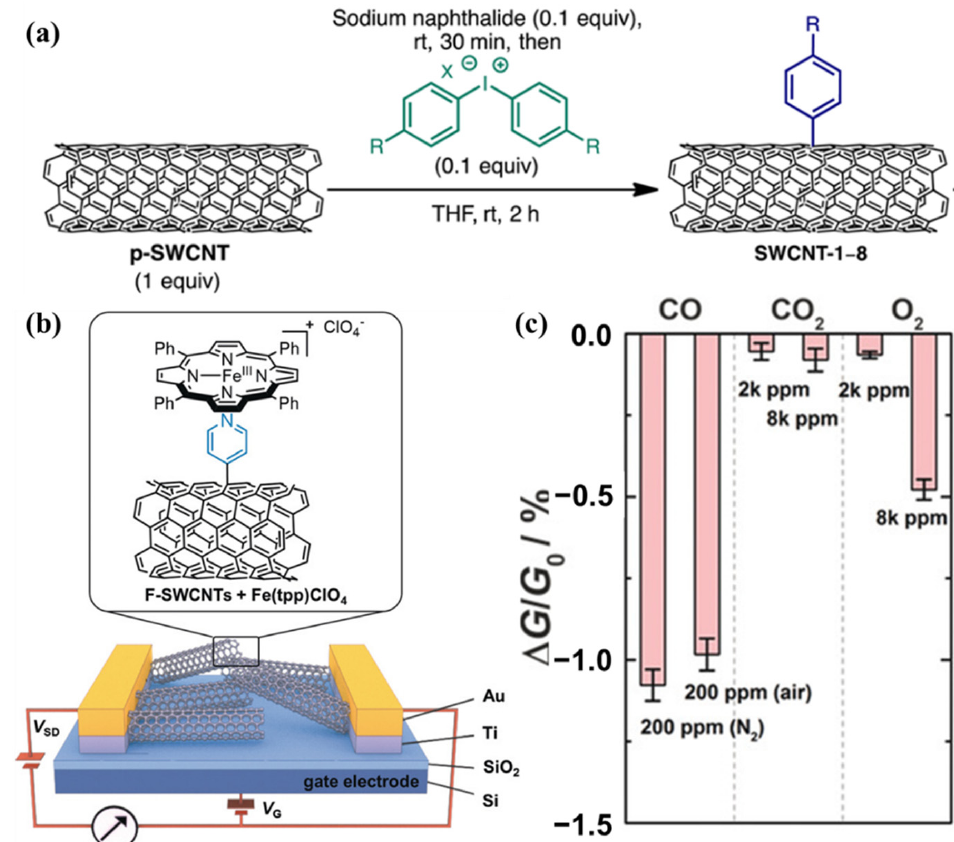
Figure 9. ( a ) Schematic of the covalent functionalization of CNTs by iodonium salts. Reprinted with permission from [106], Copyright 2016, American Chemical Society. ( b ) Bio-inspired carbon monoxide sensor. Schematic of a FET substrate with source-drain electrodes, a SiO 2 dielectric layer and a Si gate electrode. Chemical structures of a pyridyl-functionalized SWCNT and iron porphyrin (Fe − (tpp) ClO 4 ), describing the coordination of the pyridyl group to the iron center of the porphyrin. ( c ) Comparison of the responses to CO in both N 2 and air to the responses to CO 2 and O 2 . Reproduced with permission from Ref. [42]. Copyright 2017 John Wiley and Sons.